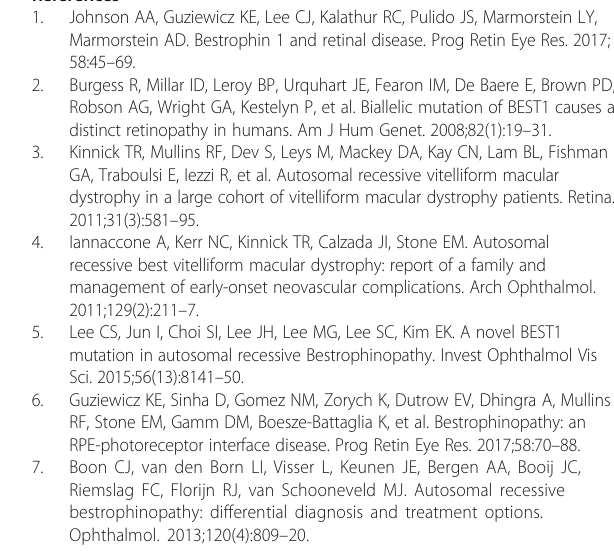
Additional file 1: Table S1. The list of 256 known retinal disease genes. Additional file 2. Figure S1. The OCT results of the proband. Abbreviations ARB: Autosomal recessive bestrophinopathy; BCVA: Best correct visual acuity; BVMD: Best vitelliform macular dystrophy; CF: Color funduscopy;